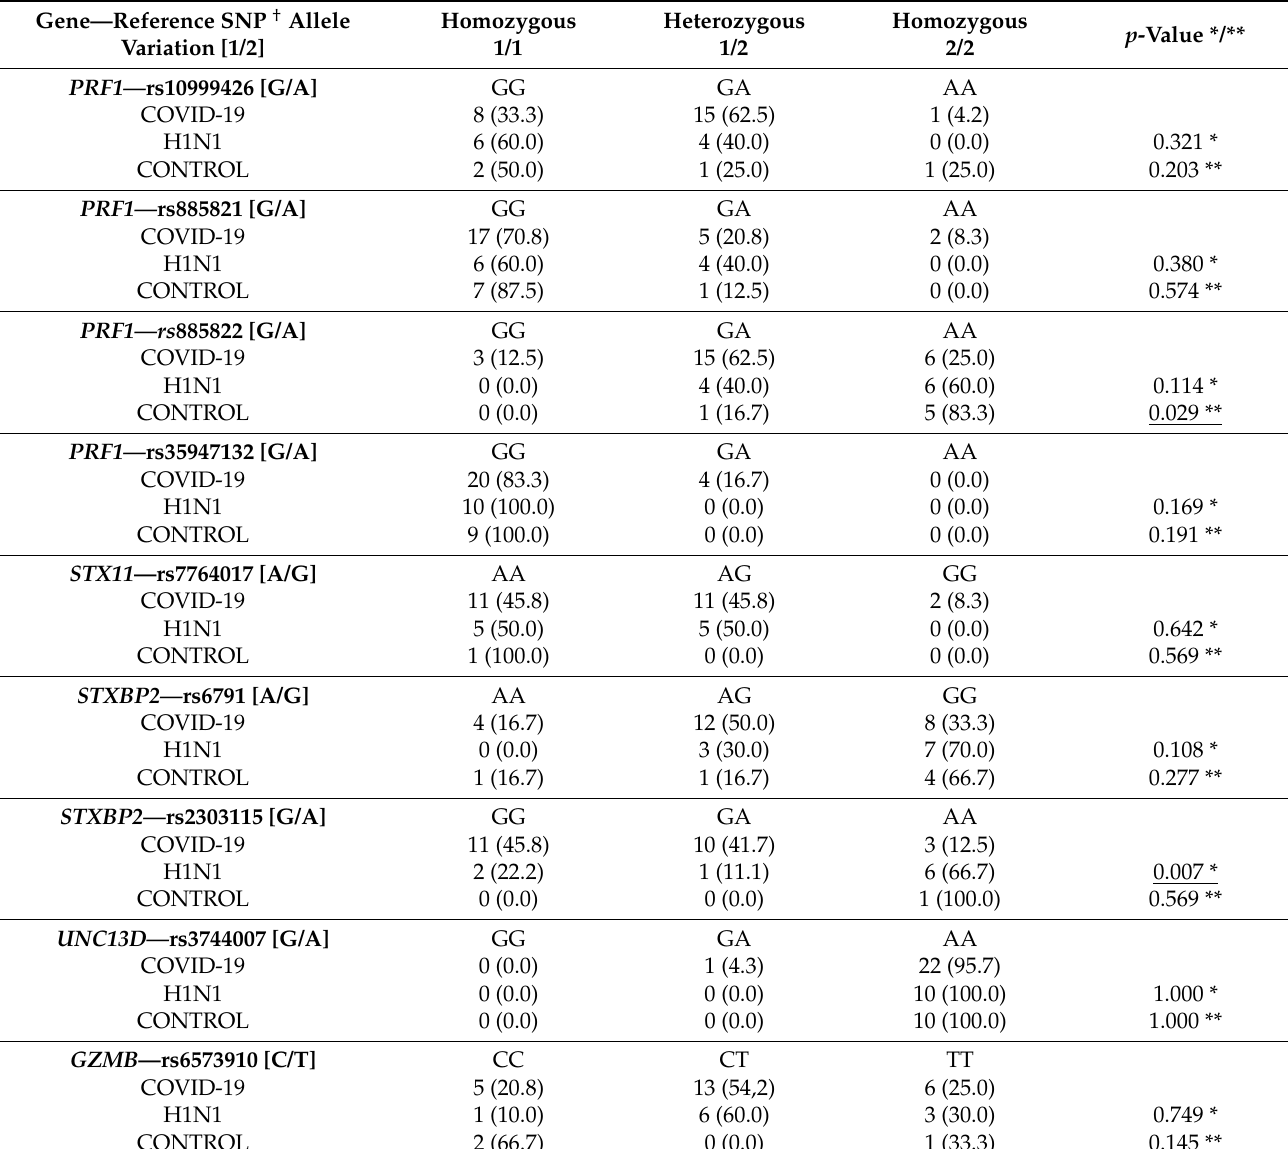
Table 2. Genotypic analysis between 3 groups (COVID-19, H1N1, and CONTROL) for PRF1, STX11, STXBP2, UNC13D, and GZMB genes in the addictive